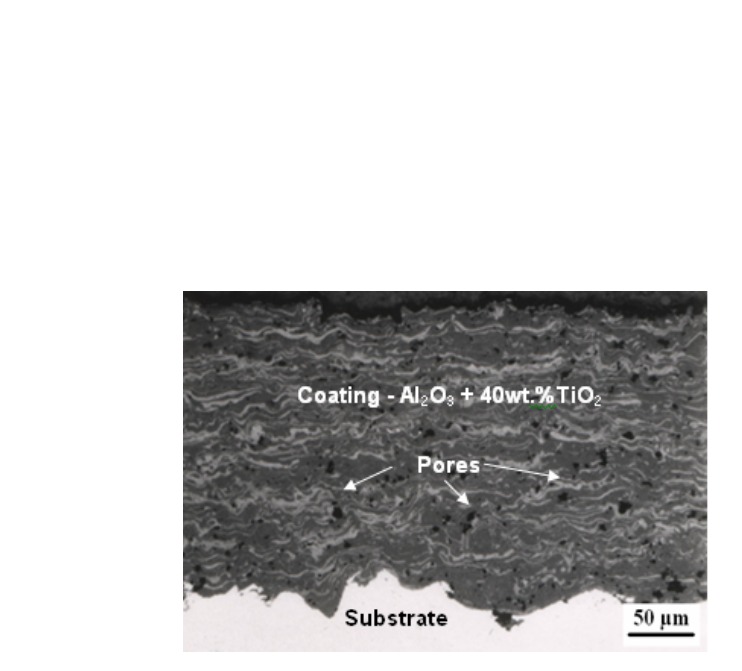
Figure 5 – Al 2 O 3 –40%wt.TiO 2 coating microstructure deposited with 900A Slika 5 – Mikrostruktura Al 2 O 3 –40%tež.TiO 2 slojeva prevlake deponovane sa 900A